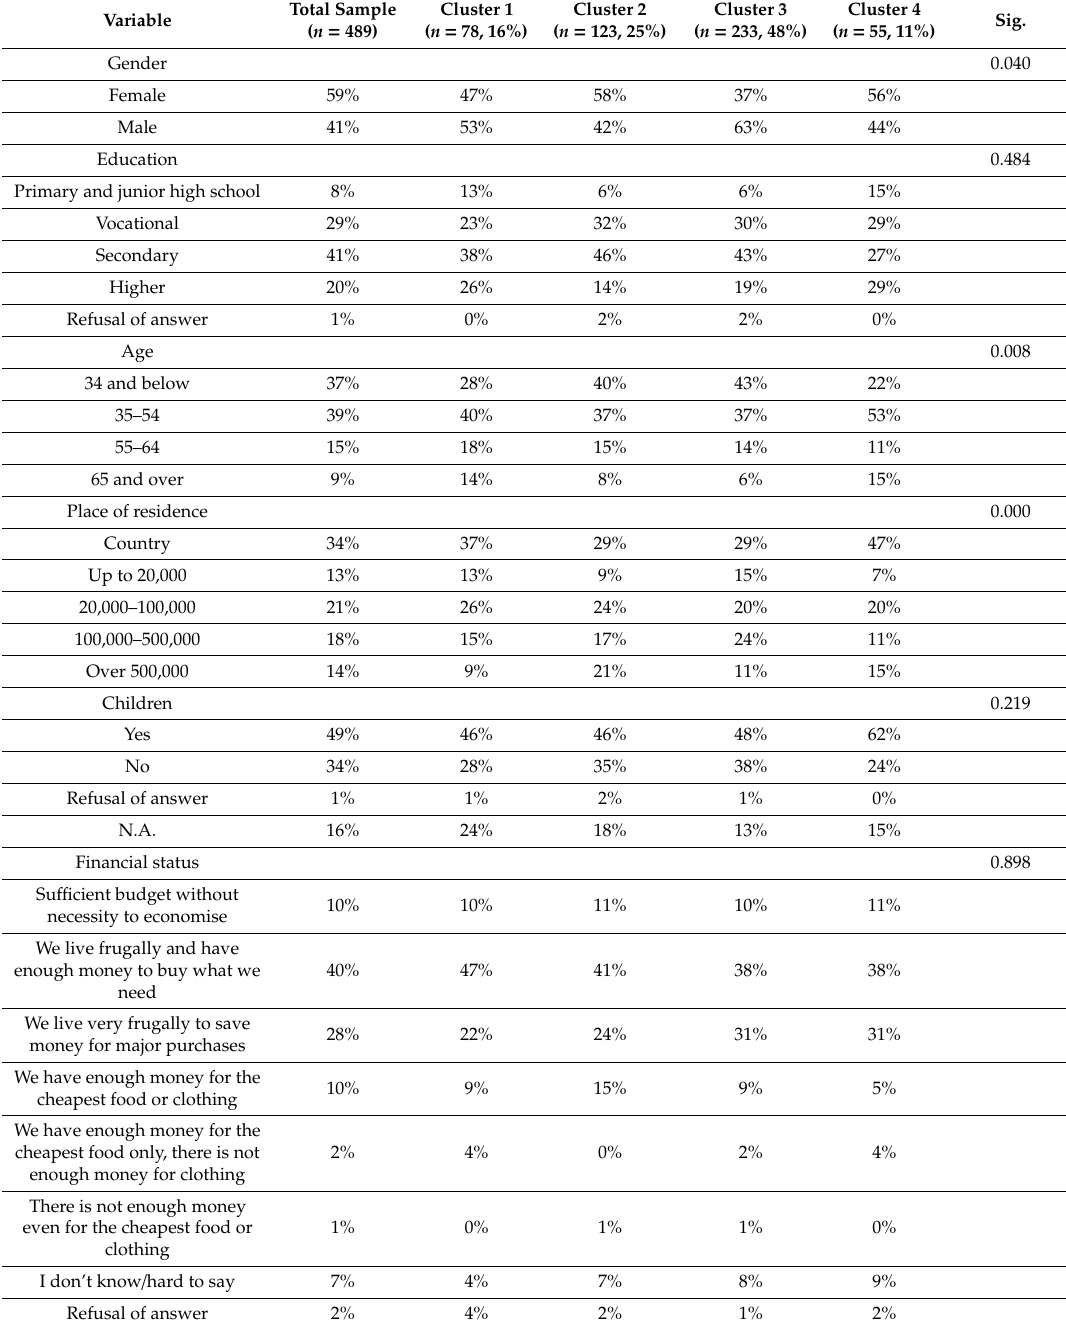
Table 3. Socio-demographic profile of the total sample and the clusters identified (%) ( N =